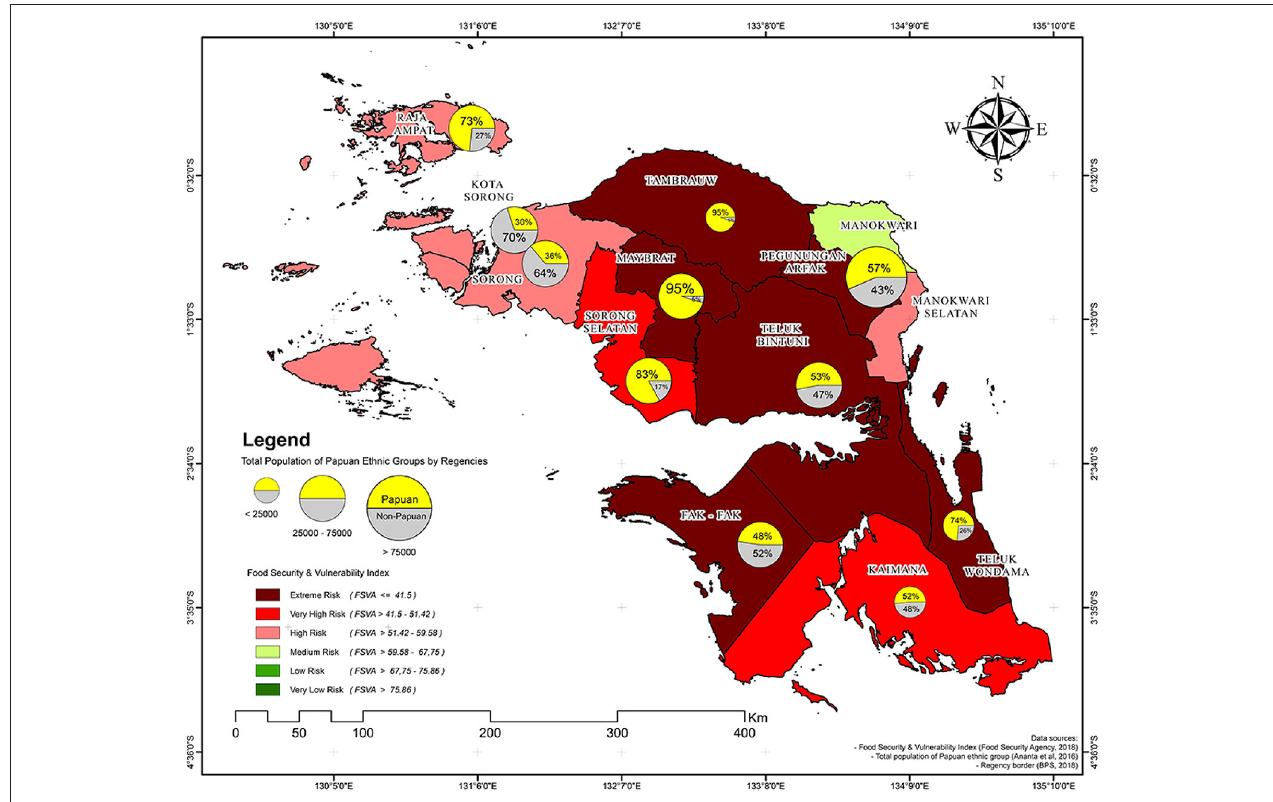
FIGURE 5 | Distribution of papuan ethnic groups and food security index (FSI) in West Papua a . a The position and size of the circle on the map describes the total number of populations by regency according to the 2010 population census; In 2010, the regencies of Pegunungan Arfak and Manokwari Selatan were part of the Manokwari Regency; The pie chart represents the percentage of Papuan (yellow) and non-Papuan (gray) in the population, based on Ananta et al.